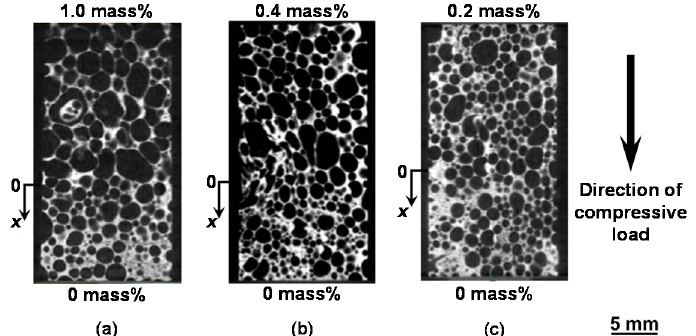
Figure 1. Pore structures of functionally graded (FG) aluminum foams with combinations of ( a ) 1.0–0 mass % TiH 2 ; ( b ) 0.4–0 mass % TiH 2 ; and ( c ) 0.2–0 mass % TiH 2